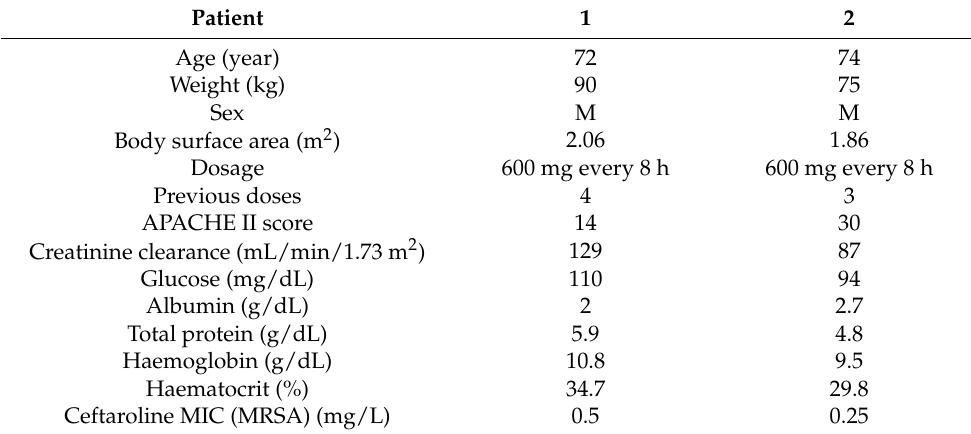
Table 2. Data for the critically ill patients.